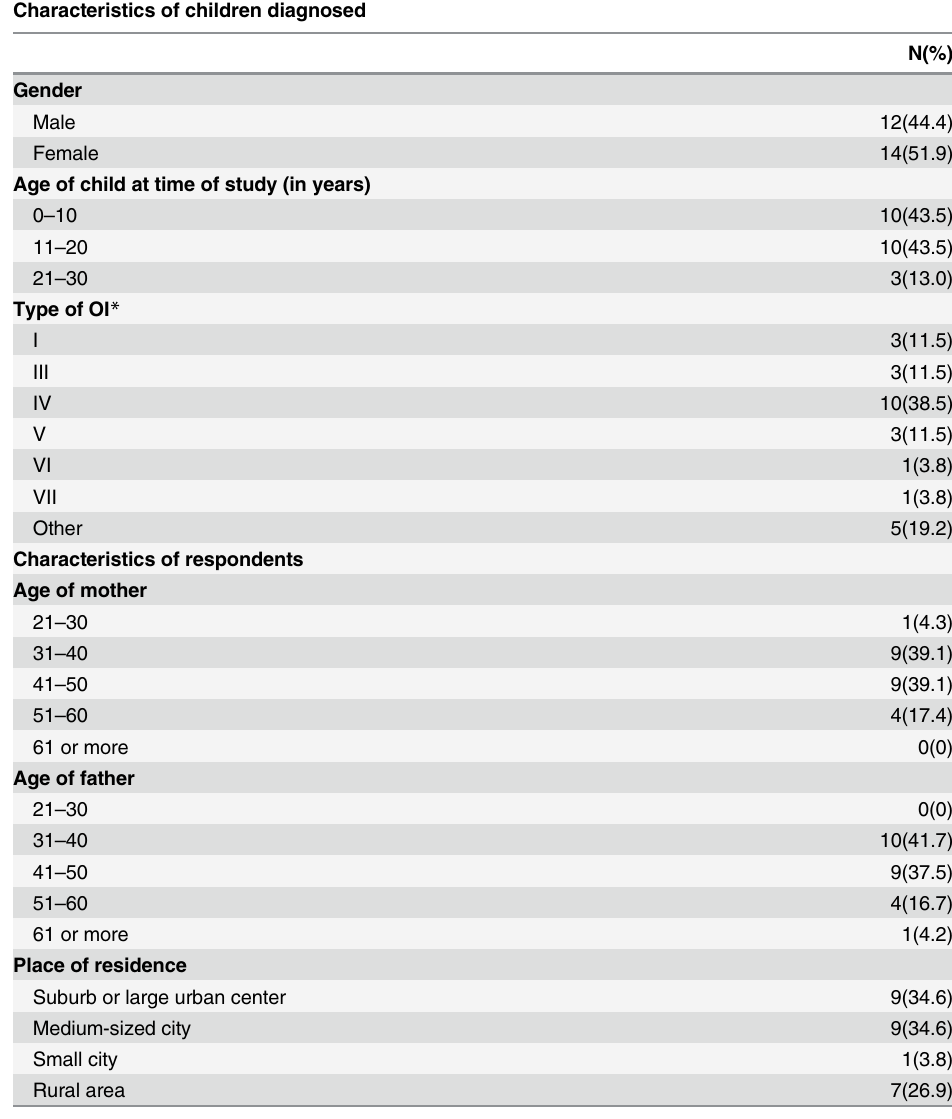
Table 1. Characteristics of respondents and their children diagnosed with OI *